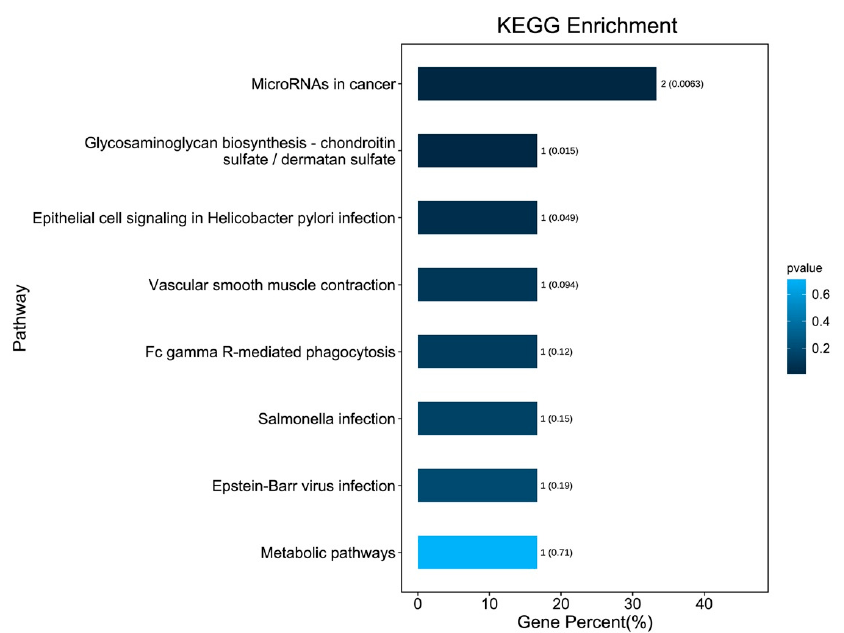
Figure 4. KEGG signaling pathway enrichment analysis for 10 DEGs. The bars indicate the percentage of genes involved in pathway terms; the numbers beside the bars indicate the gene number, and numbers in parentheses represent the p value.